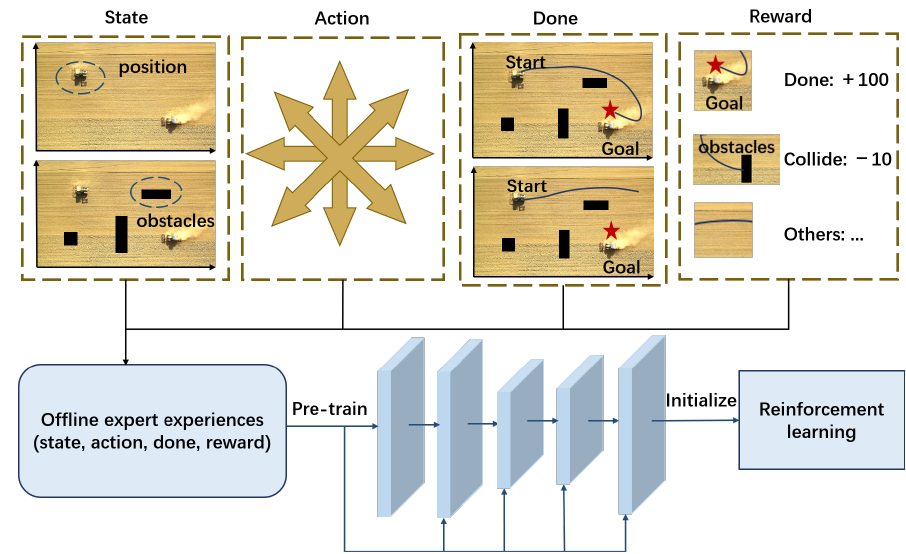
Figure 4. The offline expert experience pre-training